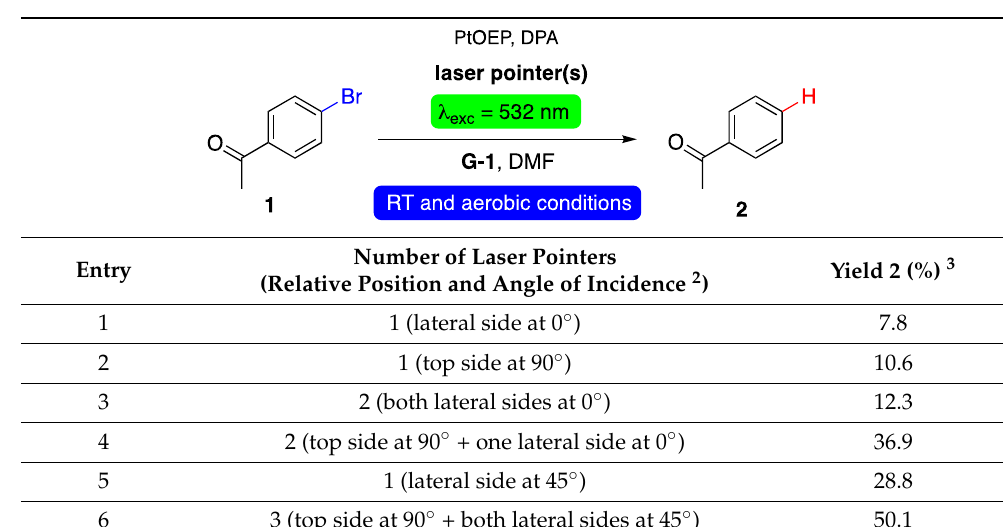
Table 1. Photoreduction of 4 ′ -bromoacetophenone ( 1 ) using laser pointers with different configurations.